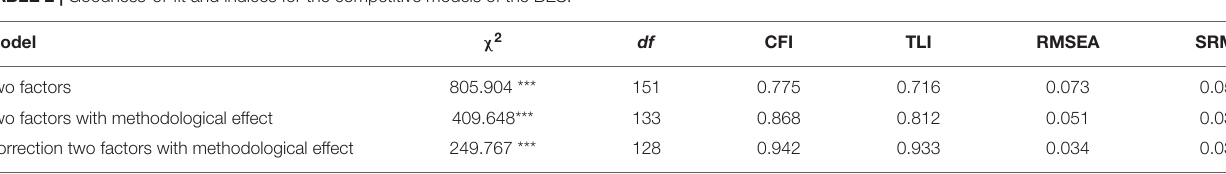
TABLE 2 | Goodness-of-fit and indices for the competitive models of the